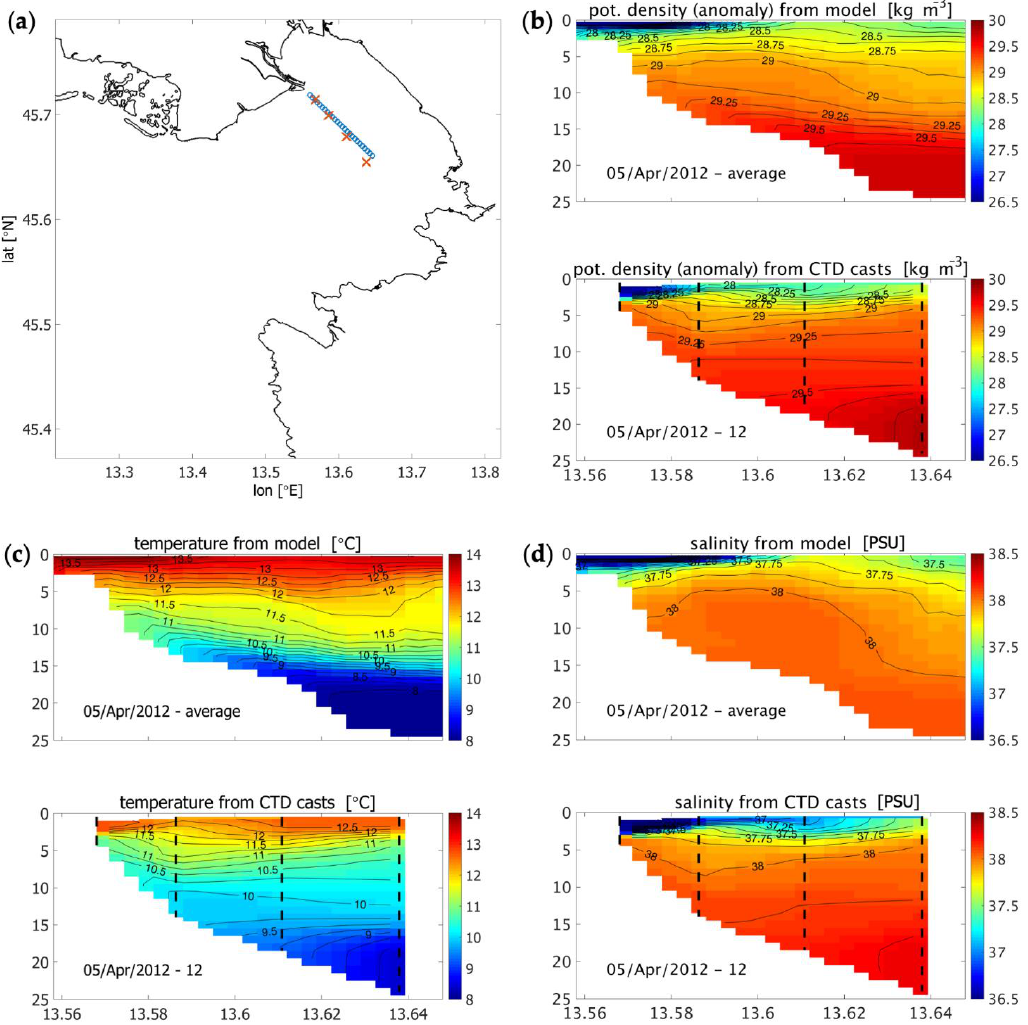
Figure 6. Vertical sections of potential density anomaly ( b ), temperature ( c ) and salinity ( d ) extracted from model output (top panels) and derived from CTD casts (bottom panels). The position of the transects (model: blue circles, CTD: red crosses) is shown in panel ( a ).